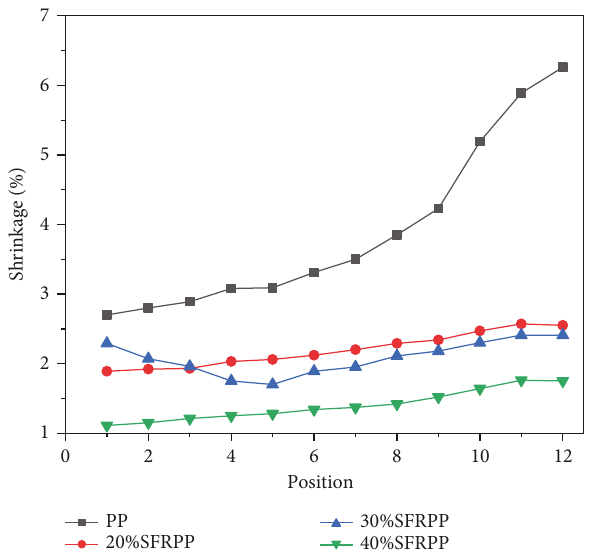
Figure 8: Effects of fiber mass content on the shrinkage of OWAIM